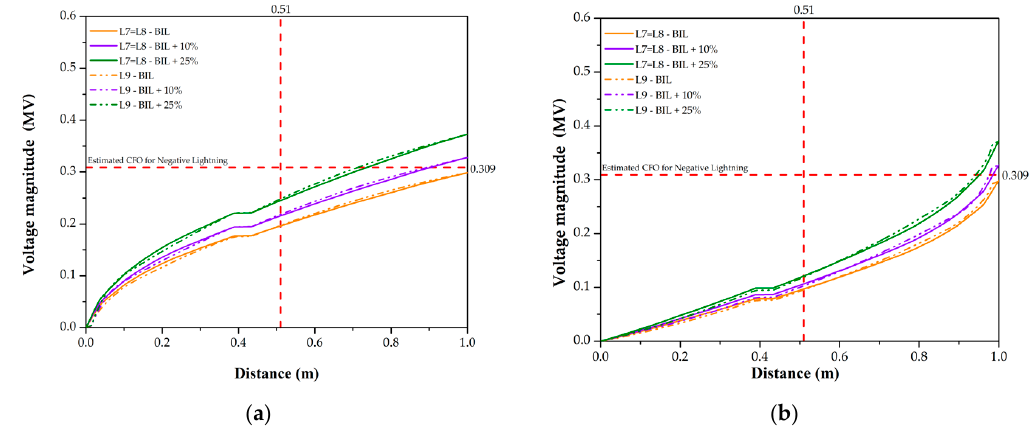
Figure 14. Voltage magnitude due to ( a ) backflashover, and (b ) shielding failure activities. Table 12. The voltage magnitude and the percentage difference between CFO and simulation results. Phase-to-Earth Minimum Percentage Difference between Types of Overvoltages Applied BIL Clearance at Crossarm Estimated CFO and Simulations (%) Section